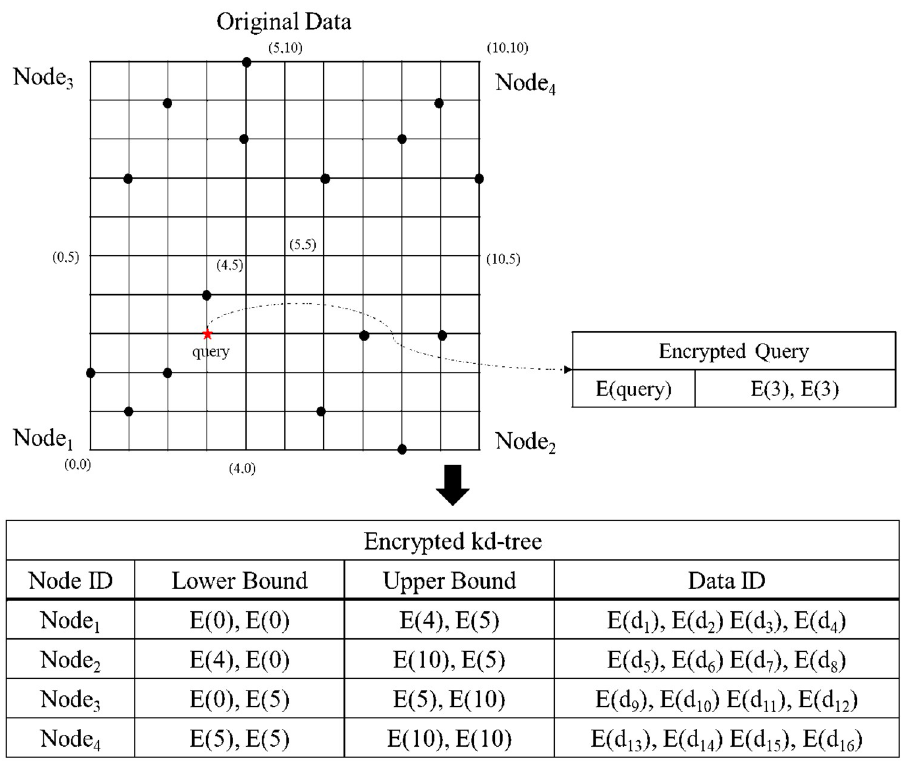
Fig 4. Data and query used in